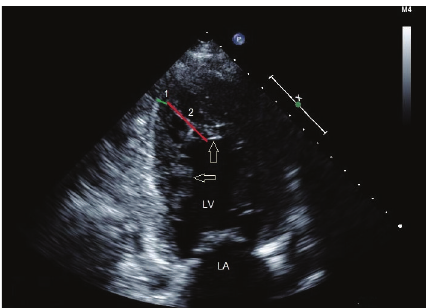
Figure 1: CT scan axial view showing wedge-shaped hypoenhance- ment in the left kidney marked with an arrow consistent with renal infarct.